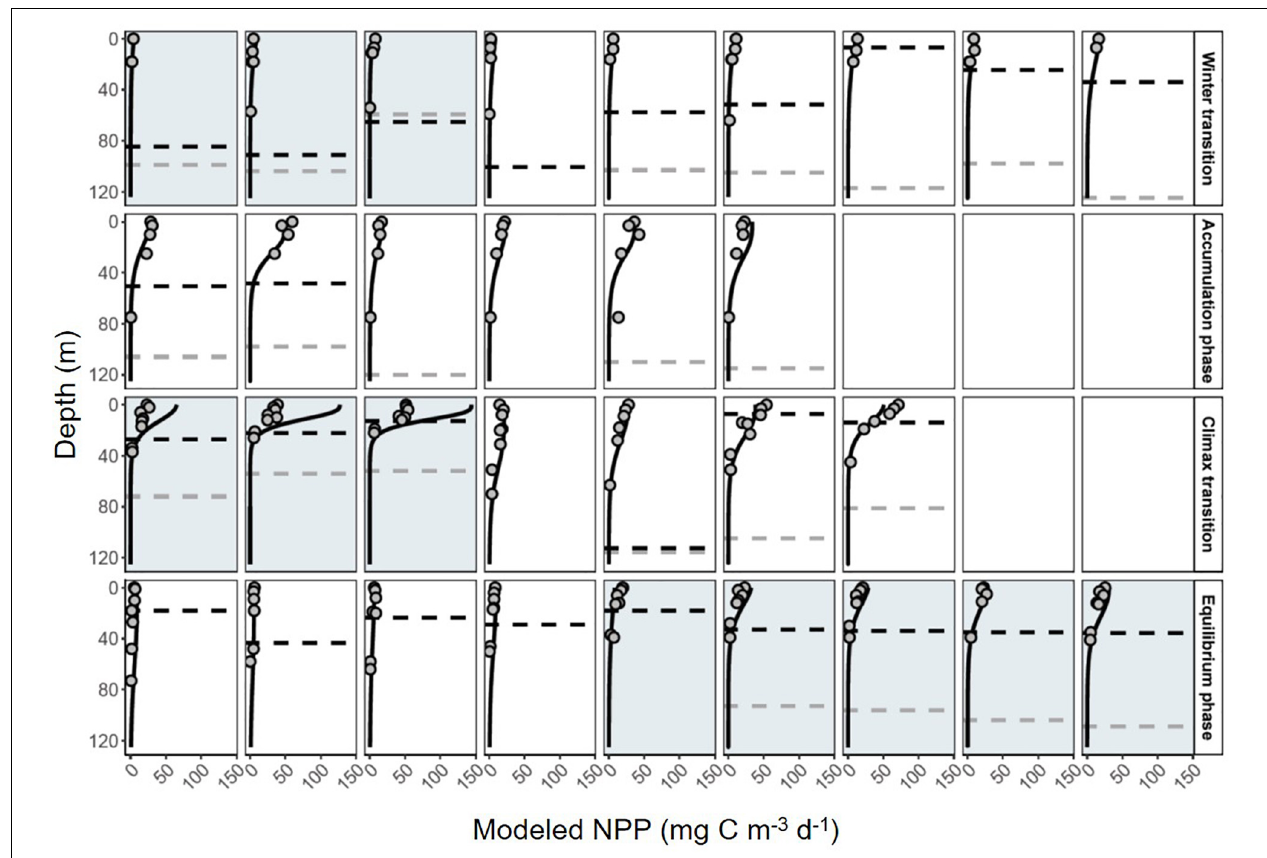
FIGURE 7 | Daily profiles of net primary production (NPP) during the NAAMES field campaign. Black solid line indicates depth-resolved (1 m) model estimates of NPP. Gray circles are discrete estimates of carbon-uptake measured in 24 h 14 C bottle incubations. Dashed black line shows the depth of the mixed layer. Dashed gray line shows the depth of the euphotic zone. White boxes indicate the station was in the subtropical region, gray shading indicates stations in the subarctic. Each row is a different phase of the annual cycle (labeled on right).